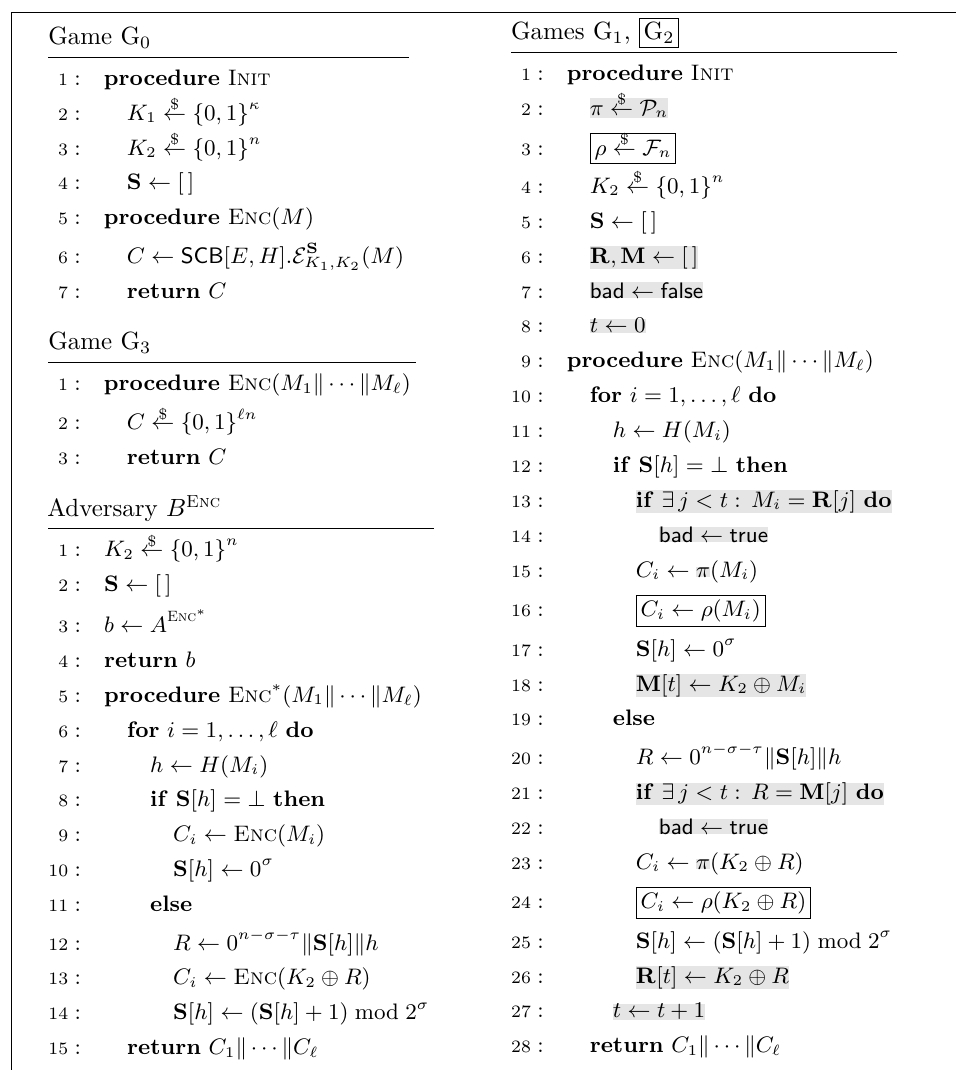
Figure 6: Games G 0 –G 3 and adversary B for the proof of Theorem 1. Changes and additions from game G boxed code therein is exclusive to game G